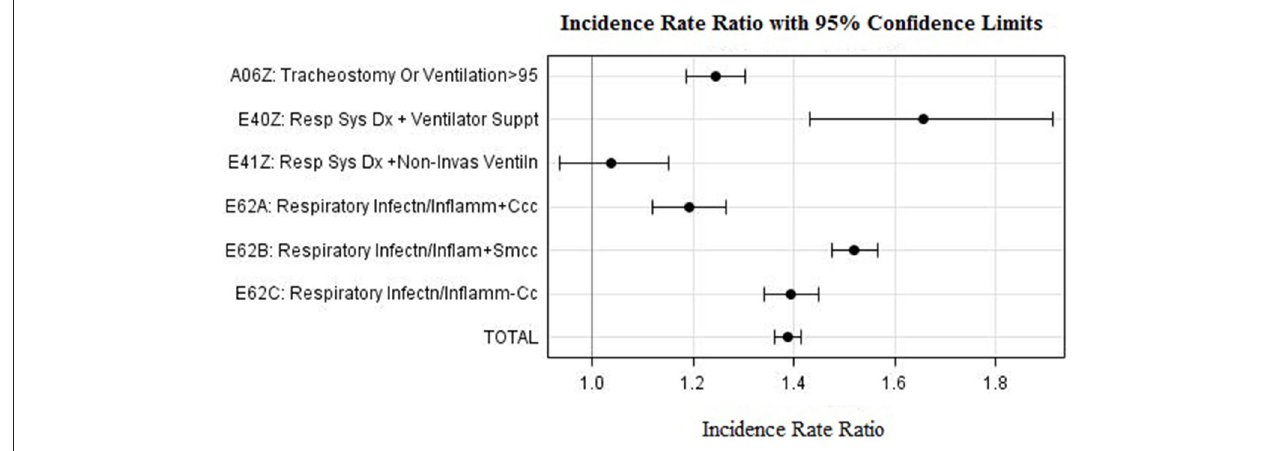
FIGURE 3 | Incidence Rate Ratio for COVID-19 related DRGs during 2020 as compared to period